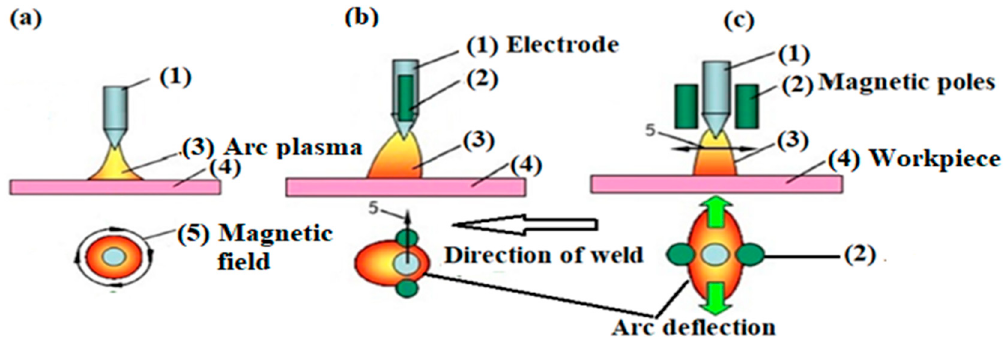
Figure 7. Weld arcs ( a ) without a magnetic field ( b ) with the TEMF, and ( c ) with the LEMF [23].